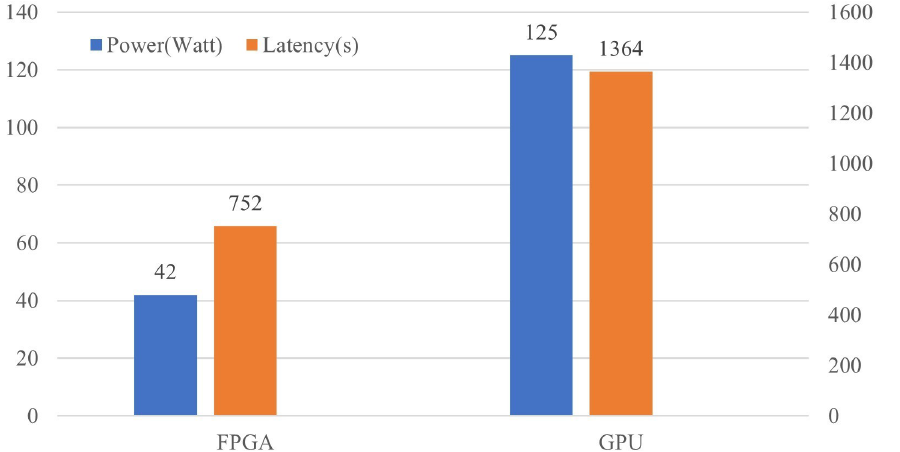
Figure 8. Power and Latency on FPGA and GPU.